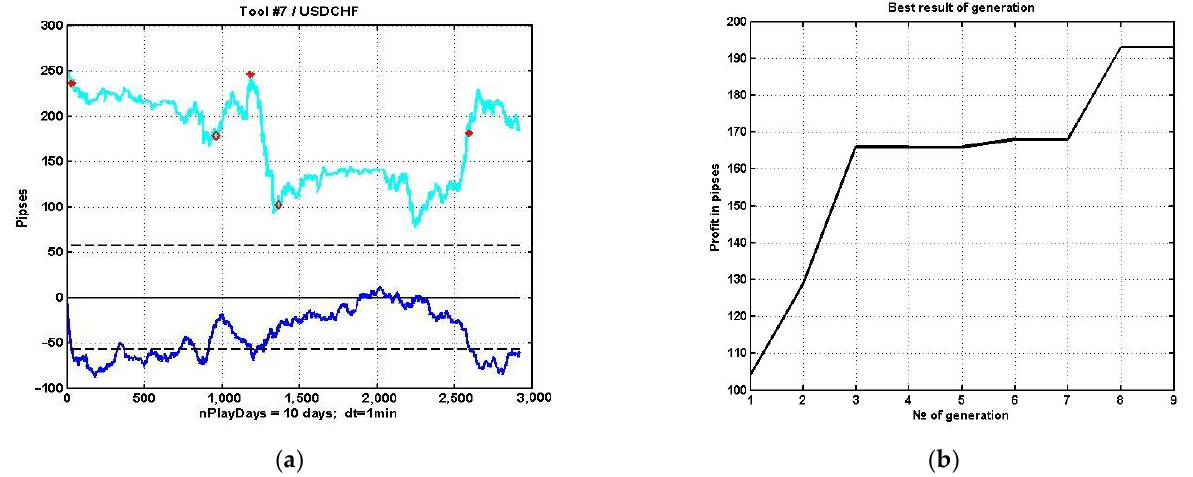
Figure 13. ( a ) An example of a suboptimal control strategy using an adaptive MR oscillator. ( b ) The dependence of the gain growth on the generation number for this strategy.